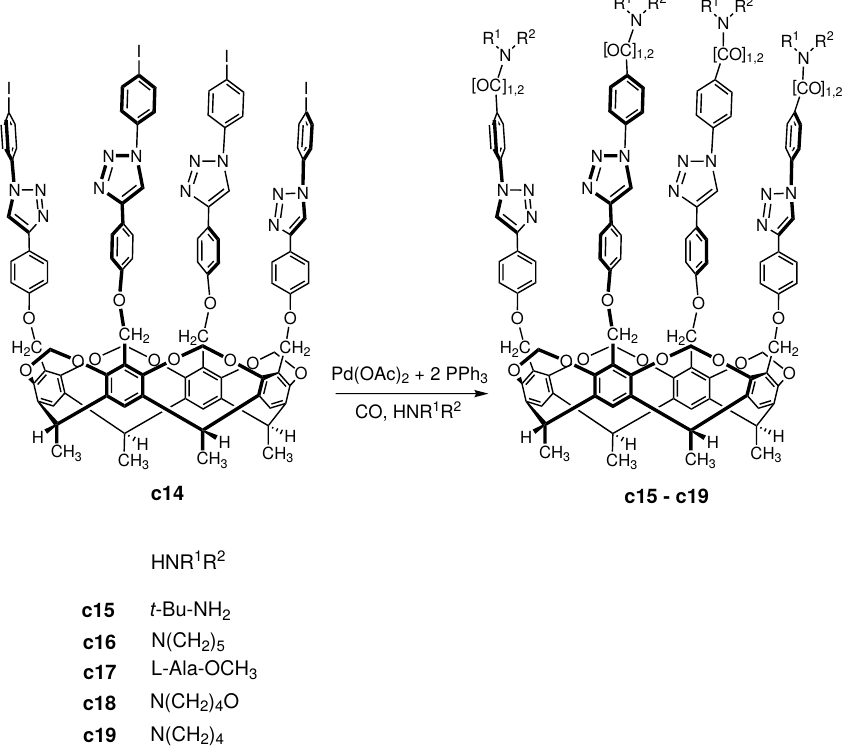
Figure 20. Scheme of the aminocarbonylation reaction on deepened cavitand